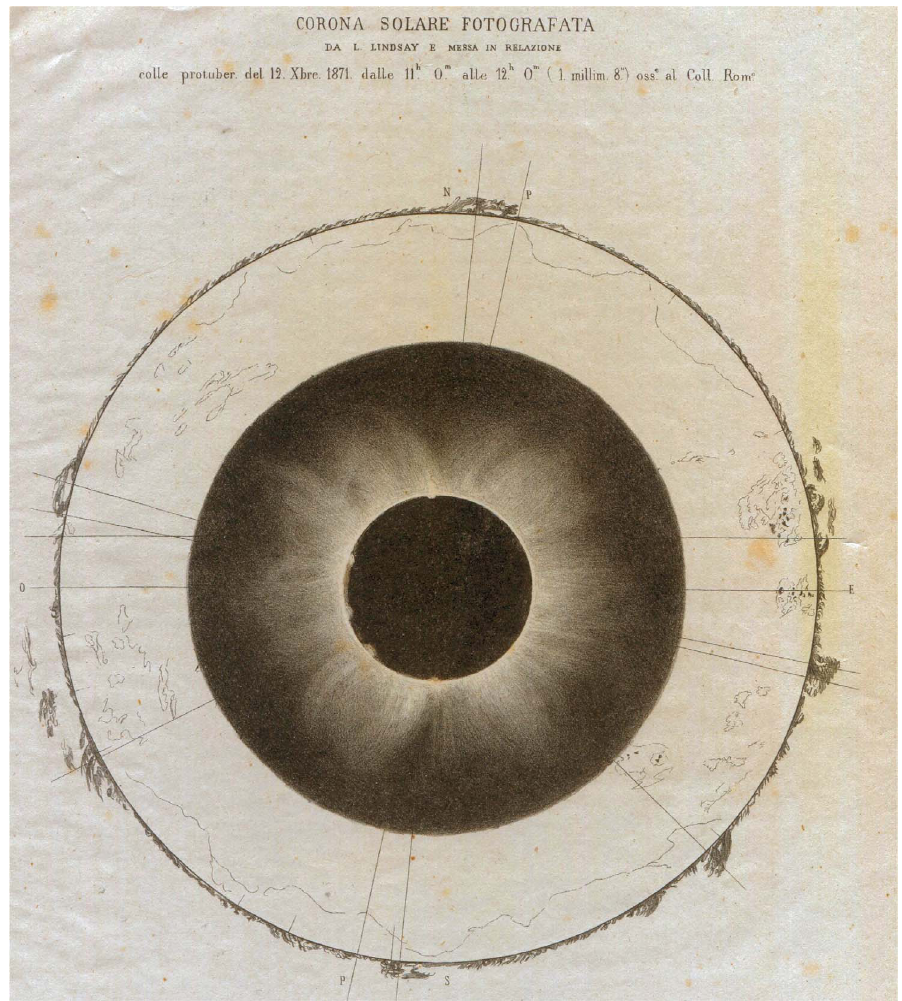
Fig. 2. The fi gure shows the photograph of the total eclipse of 12 December 1871 taken by Lindsay in comparison with the chromosphere protuberances observed from 11:00 am to 12:00 pm by the Roman College. From Secchi ’ s communication Sulla distribuzione delle protuberanze solari e loro relazione colle macchie (Secchi,